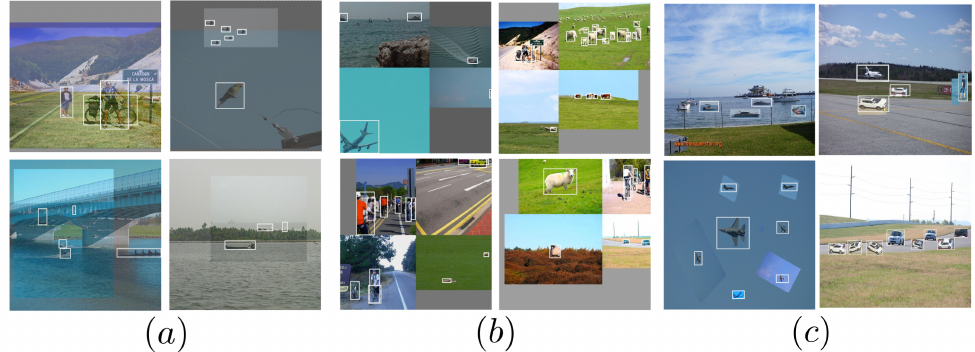
Figure 9. Visualization of multiple data augmentation methods. Mixup, Mosaic, and Consistent Mixed Cropping are listed in each column from left to right represented by ( a – c